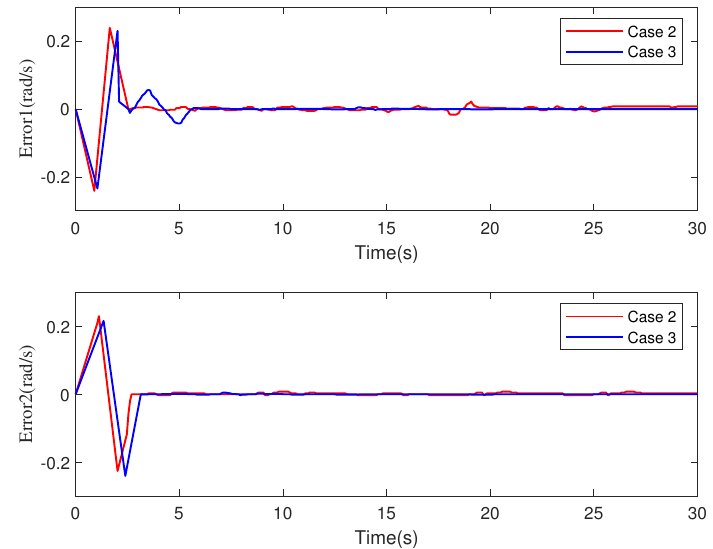
Figure 7. Velocity estimation errors with model uncertainty in Case 2 and Case 3.